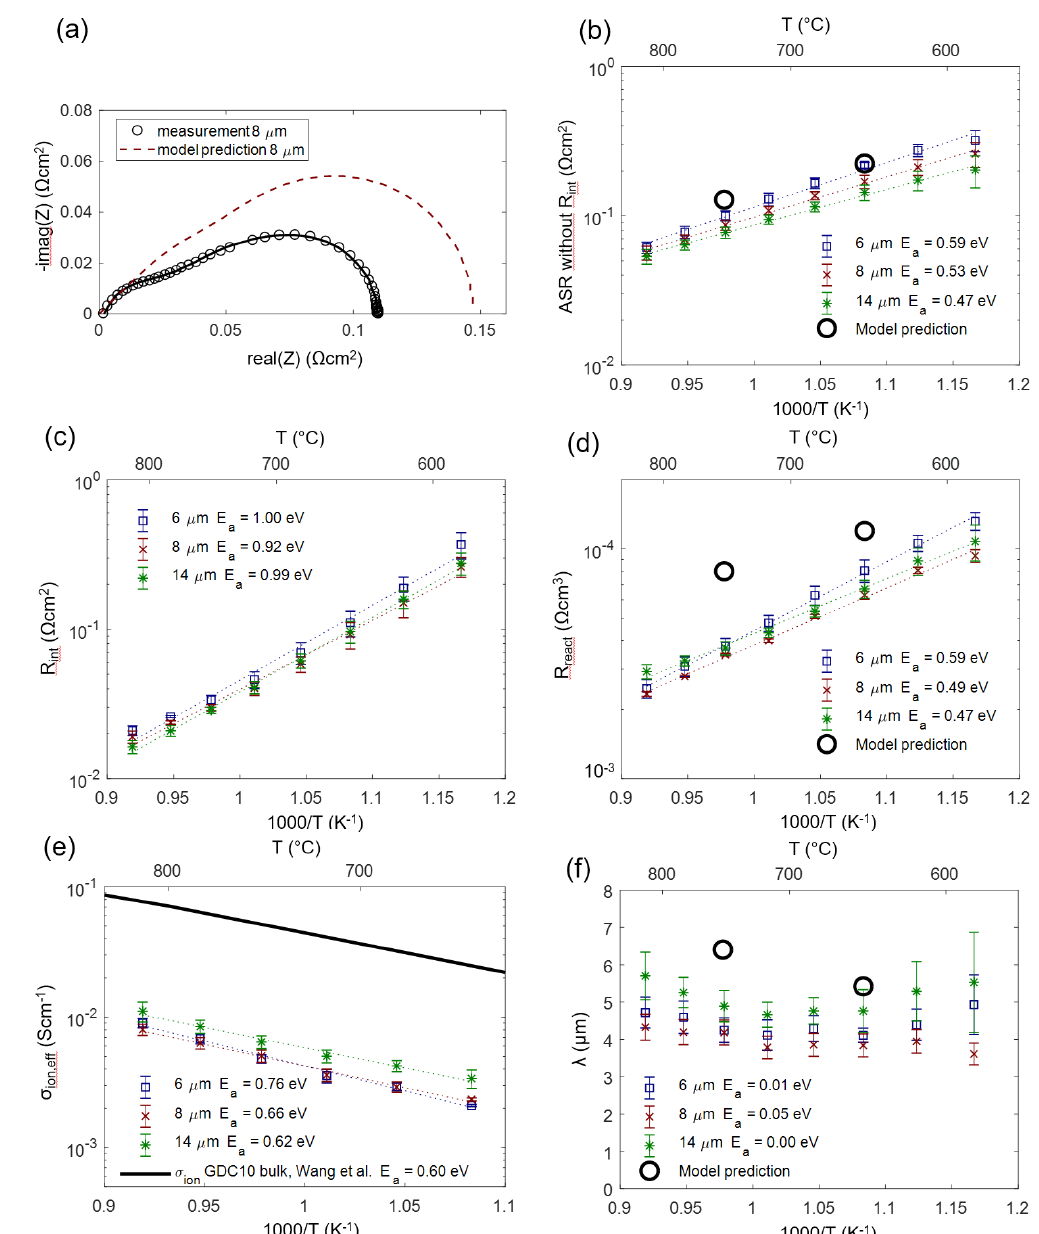
Figure 12. ( a ) Measured impedance of an 8-µm-thick anode at 750 °C (circles) with a least squares fit (black line) compared to the model prediction with parameters from Table 2. ( b ) ASR of the electrode after subtracting the interfacial resistance R int compared to the model prediction summarized in Table 2. ( c ) ASR for the ion transfer at the YSZ-GDC interface. ( d ) Effective (volumetric) reaction resistance. ( e ) Effective ionic conductivity compared to the literature value of dense GDC10 [67]. ( f ) Electrochemically active thickness. Calculated activation energies (E a ) are given in the legends.